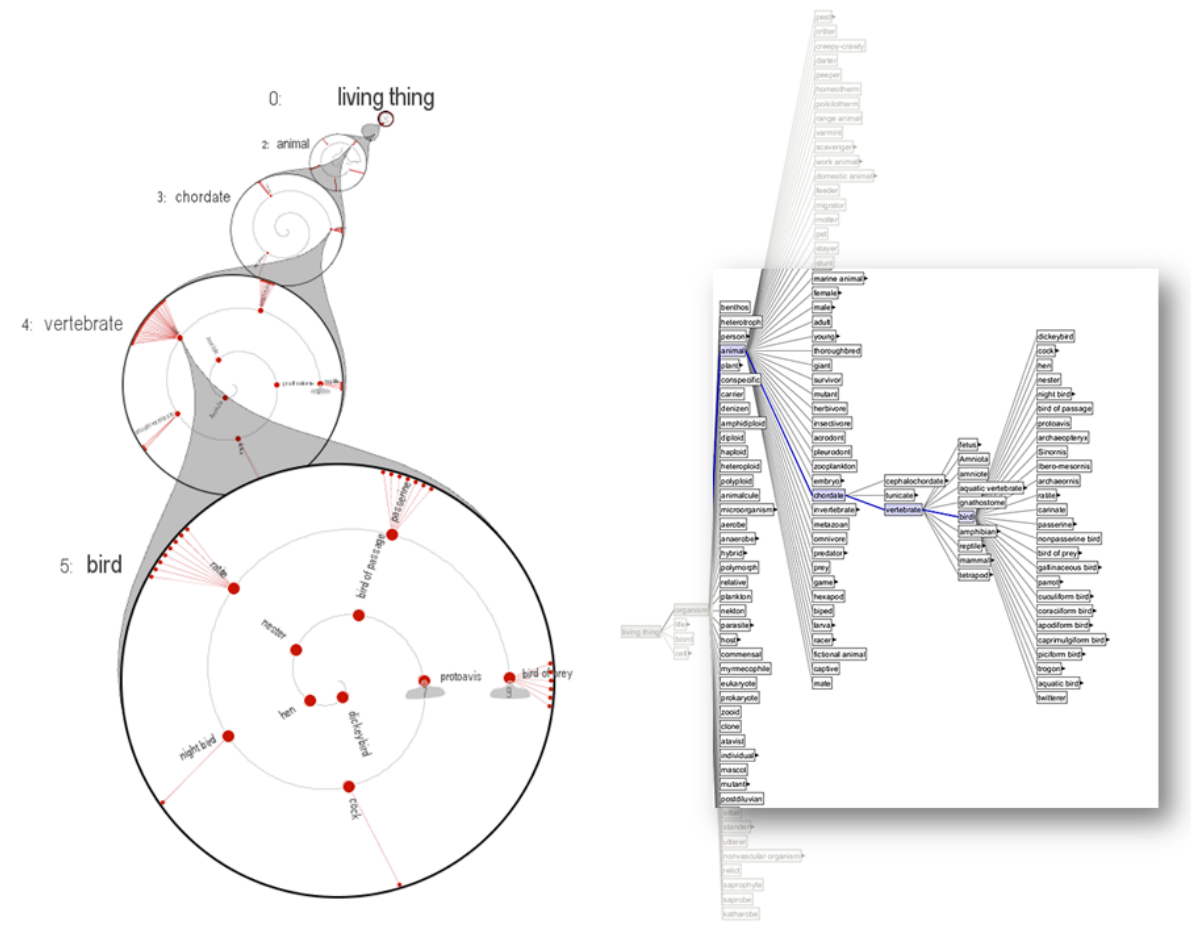
Figure 15. Comparing PasileyTree and SpaceTree: Left: in PaisleyTree the overall size is fixed, so the full structure stays on screen. Right: SpaceTree requires interactive adjustments to view the full structure (in this image the part displayed on screen has been